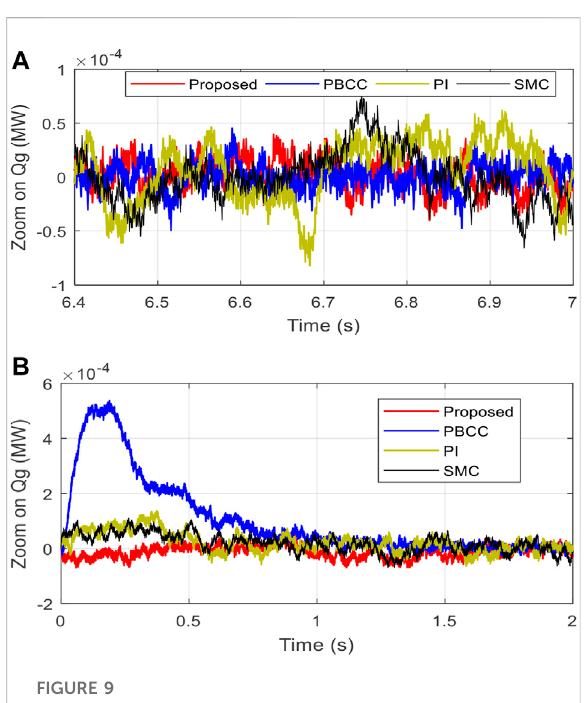
FIGURE 9 Reactive power response of the tested